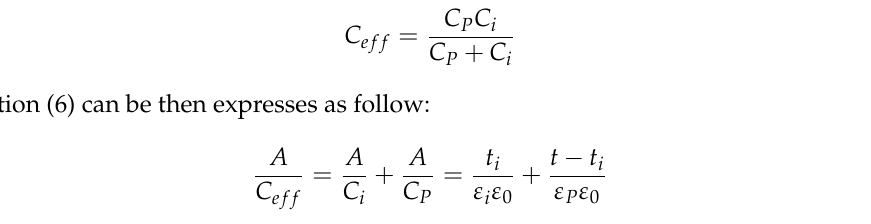
Figure 3. ( a ) Tunability curves which were calculated from the corresponding dielectric constant curves (Figure 2d), and ( b ) dielectric loss curves, of PLZT films as a function of film thickness measured at 800 kV/cm and 100 kHz. Figure 4 shows the dielectric, tunability and FOM properties of the 1000 nm PLZT films, measured at 800 kV/cm, as a function of operating frequency. The dielectric constant at a certain field ( ε Eap ) is near-independent of frequency, and then ε r, 0 V and ( ε r ,0 V − ε Eap,max ) values show a similar trend, in which they decrease with increasing frequency (Figure 4a). Therefore, the tunability (as a ratio of ( ε r, 0 V − ε Eap,max ) and ε r, 0 V values) is also slightly re- duced. The decrease in ε r, 0 V value and tunability at high frequencies are related to free dipoles oscillating in an alternative applied electric field (such as the damped motions of dipole oscillators), due to the reduction in relaxation time ( τ = 1/frequency) [9,73,74]. Moreover, due to the increase in dielectric loss with increasing frequency (Figure 4b), it is found that the reduction rate of the FOM is much higher than that of tunability (Figure